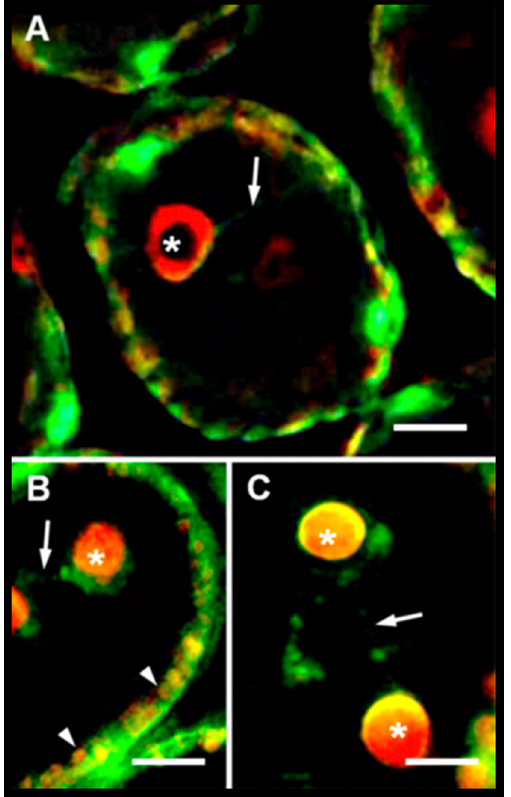
Figure 2. Actin labelling using phalloidin-FITC (A–C). Microfila- ments are represented in green and in red-orange the auto- fluorescence of CC and chloroplasts. Note that microfilament labelling is not restricted to connection structures (A,C) placed between the